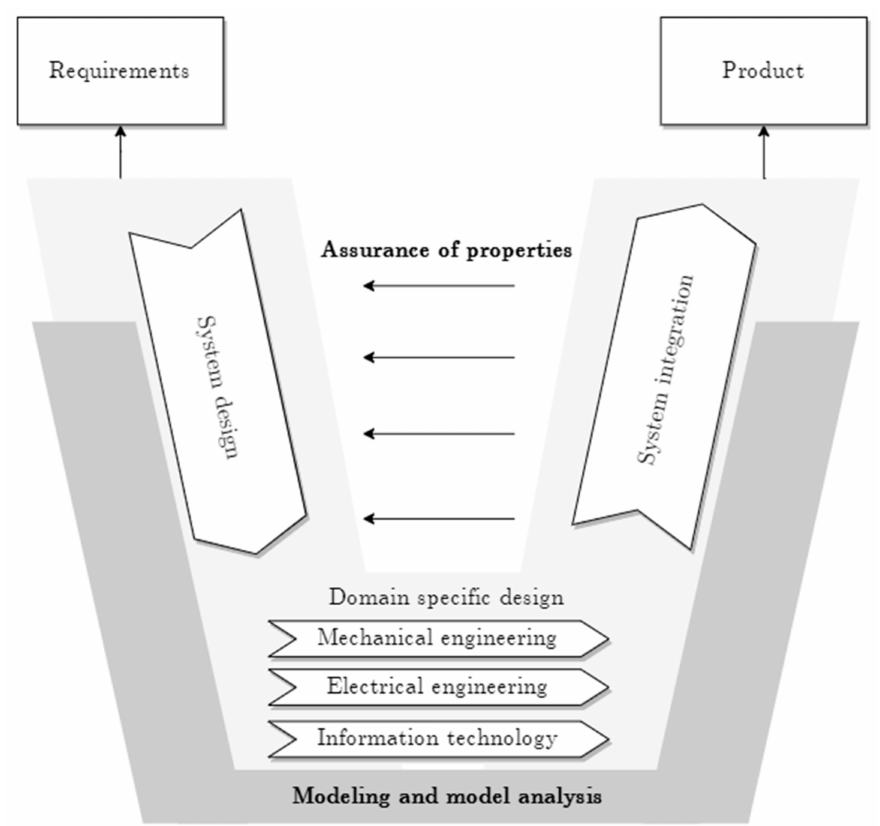
Figure 1. The V-model according to guideline VDI